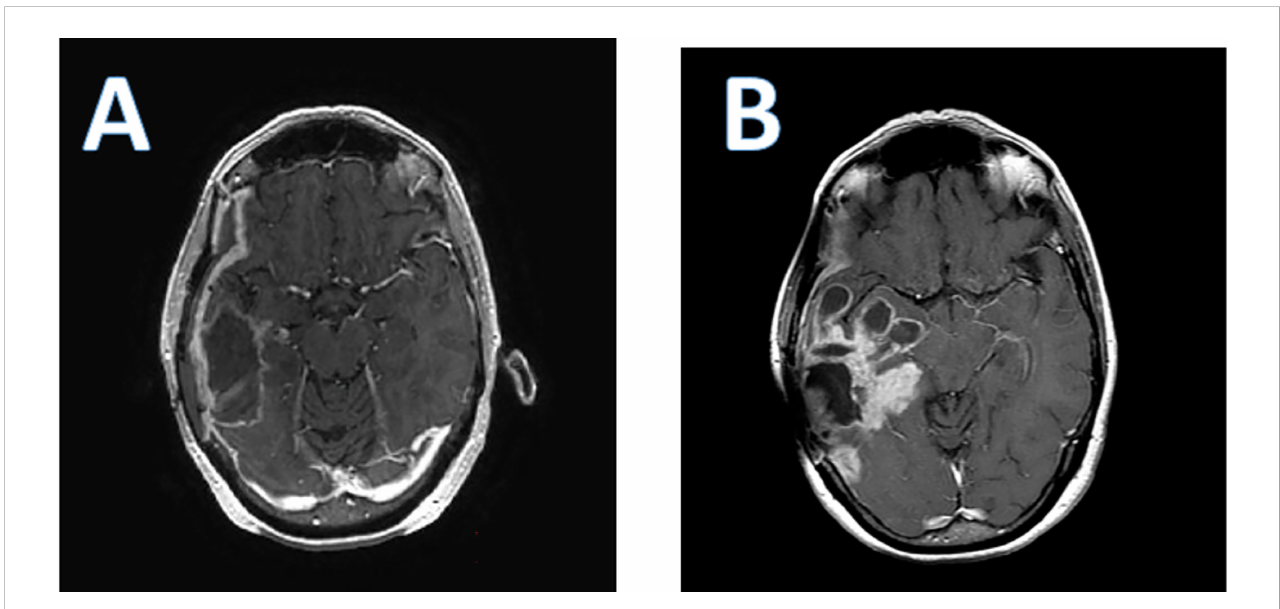
FIGURE 2 Axial T 1 post contrast enhanced brain MRI of a patient who received PVS-RIPO therapy. (A) ; baseline; (B) ; 4 months after PVS-RIPO, the MRI reveals cystic tissue degradation and parenchymal brain in fl